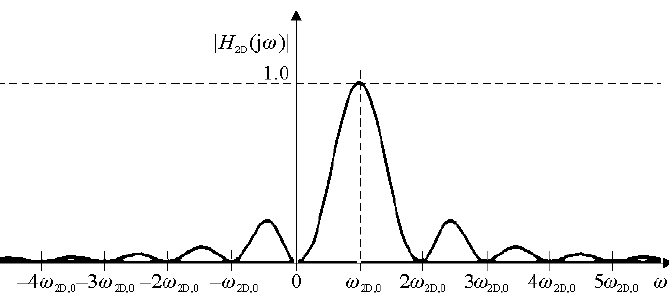
Figure 2. Magnitude part’s plot of the frequency characteristic of the 2D-FIR.